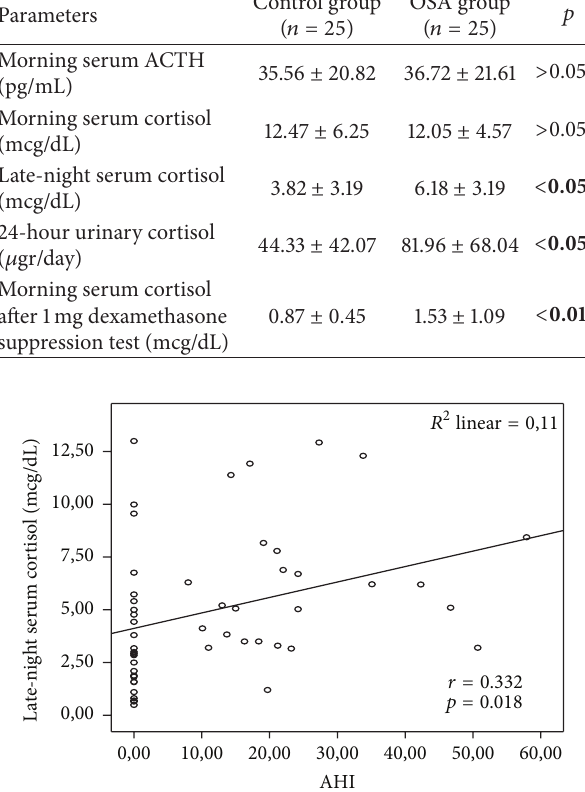
Figure 3: Pearson correlation analysis between AHI and late-night serum